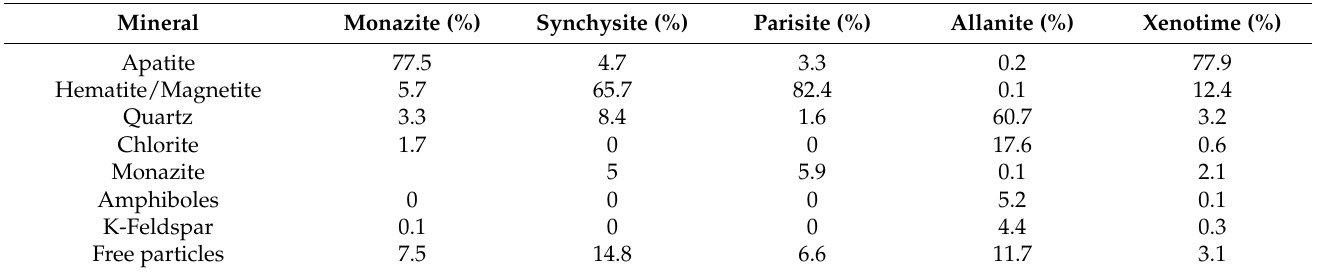
Table 3. Mineral associations of REE minerals in the flotation feed as revealed by